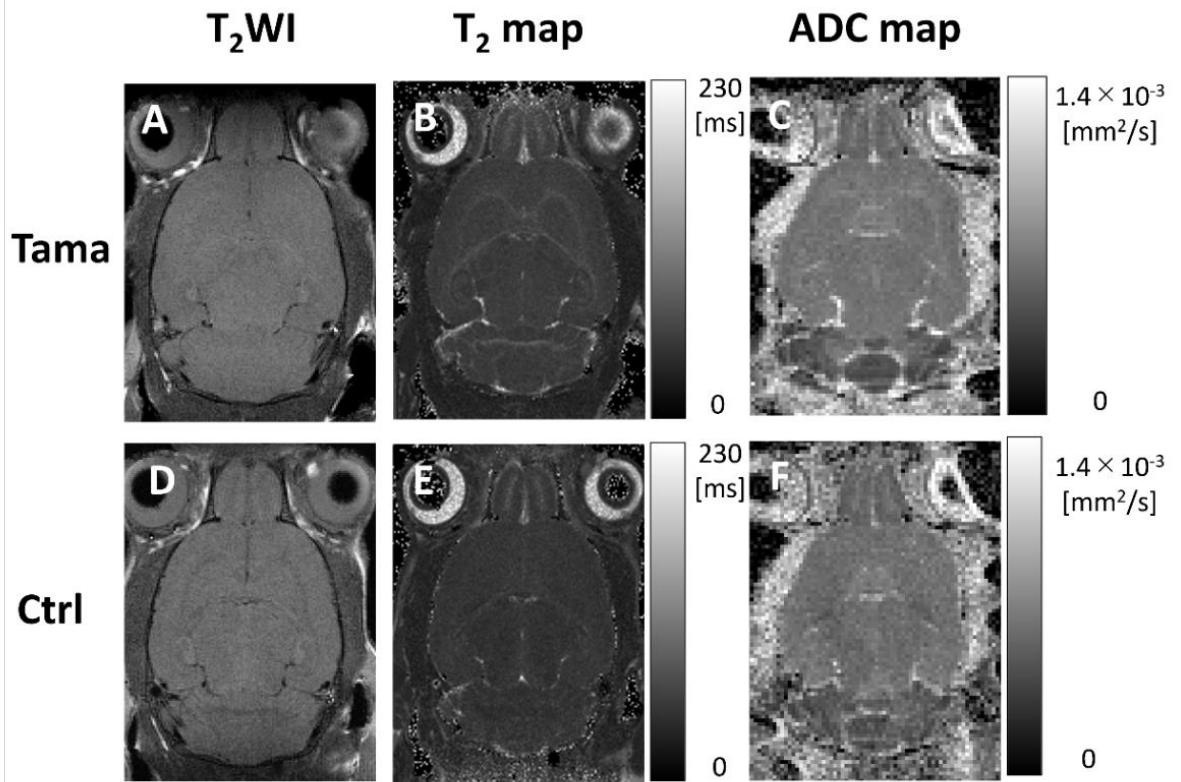
Figure 2. T 2 -weighted images, T 2 maps, and ADC maps of the Tama rats and control rats (Ctrl). The white matter intensity of the Tama rat in the T 2 -weighted image ( A ) was higher than that of the control rat ( D ). In the T 2 maps, the T 2 values in the white matter of the Tama rat ( B ) were higher than those of the control rat ( E ). In the ADC maps, the ADC values in the white matter of the Tama rat ( C ) were higher than those of the control rat ( F ).